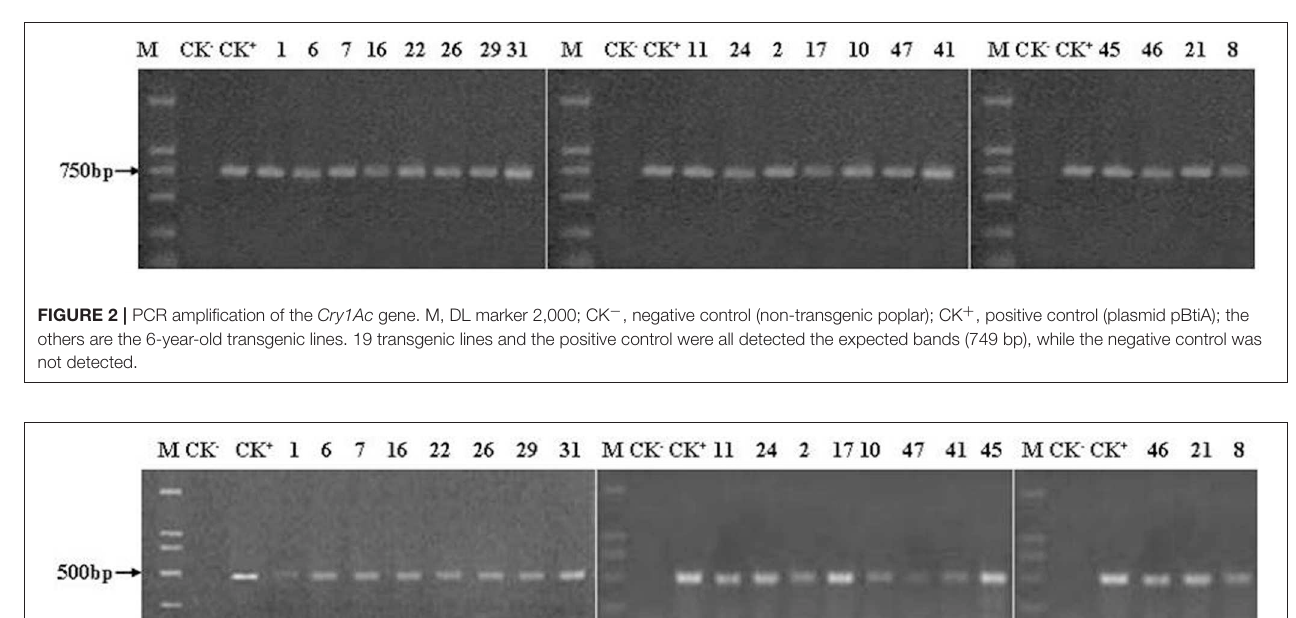
Insect Bioassay Mortality Rates Measurement The 3-year-corrected larvae mortalities of the C. anachoreta larvae are shown in Table 1 . The corrected mortality rates